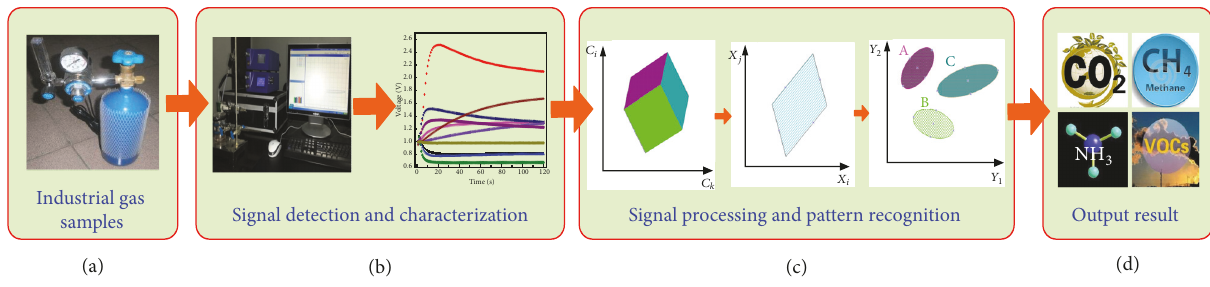
Figure 1: Industrial gas detection and identification of experimental system. (a) Gas samples storage and flow control. (b) The gas signal is detected and stored using the electronic nose (EN) system. (c) Then the pattern recognition method is used to process and identify the gas signal (c). (d) Finally the recognition result is output.